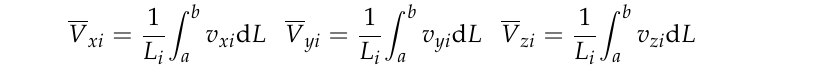
Figure 14. Contours of velocity profiles on the different cross-sections downstream of the header without FC.